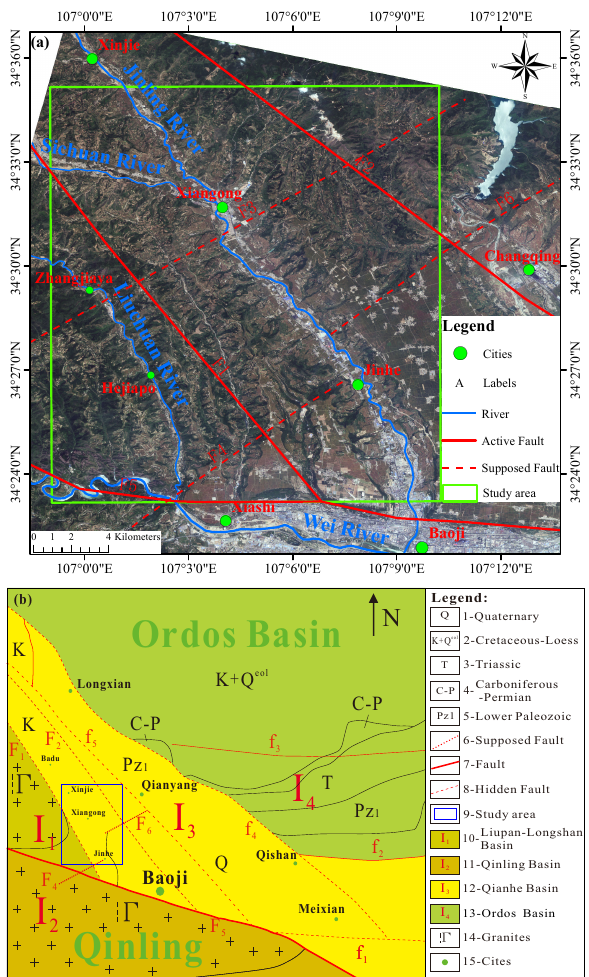
Figure 1. Study area and data collections (a) GF-1 satellite image; (b) Regional structure background (modified from China Earthquake Administration,